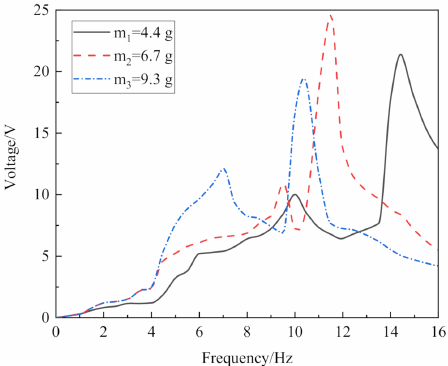
Figure 8. Open-circuit output voltage of different mass blocks at different frequencies. The voltage reached a maximum value of 24.6 V at m 2 (6.7 g) and a vibration frequency of 11.5